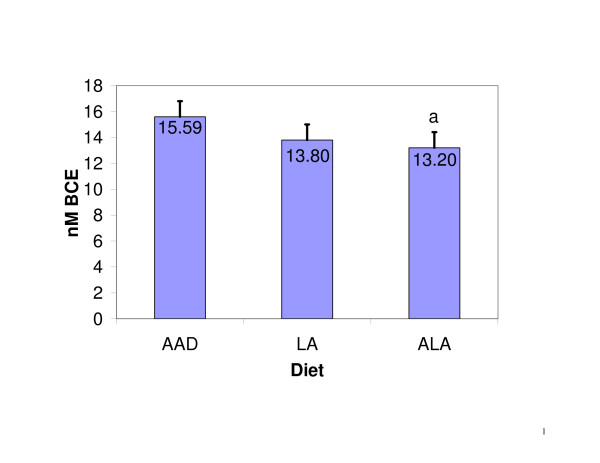
NTx levels when diets differing in fatty acid composition were consumed. ap < 0.05 when compared to AAD. Vertical bars represent the standard errors of the means.